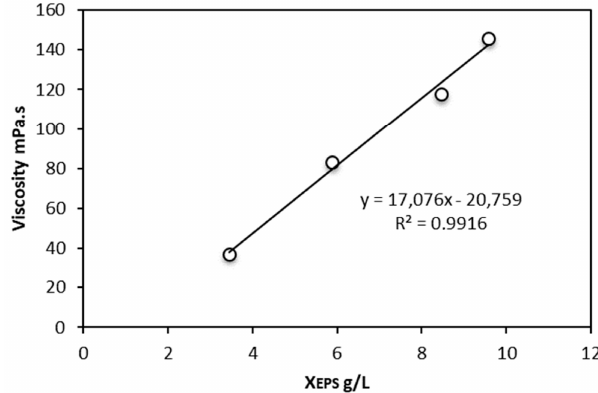
Figure 7. Microalgal culture viscosity is affected by the concentration of extracellular polysaccharides (X EPS ) in the culture medium. Table 1. Microalgal cells dry weight (Xc) and extracellular polysaccharides dry weight (X EPS ) in su- pernatants after homogenization under different pressures followed by centrifugation.